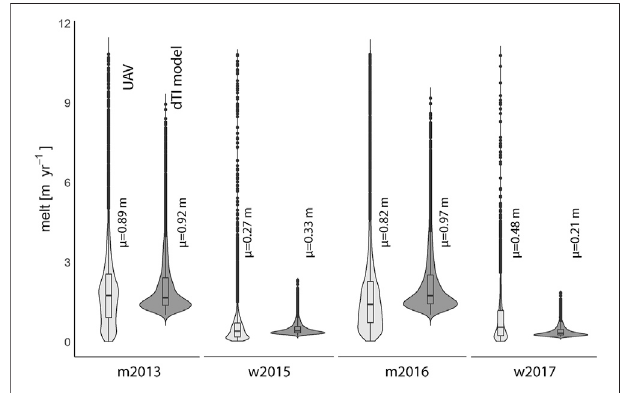
FIGURE 14 | Ice melt below debris for two monsoon ( m ) and two winter seasons( w ,see SupplementaryTableS1 forexacttimeperiods),measured by DEM differencing (UAV) and modeled with the dTI